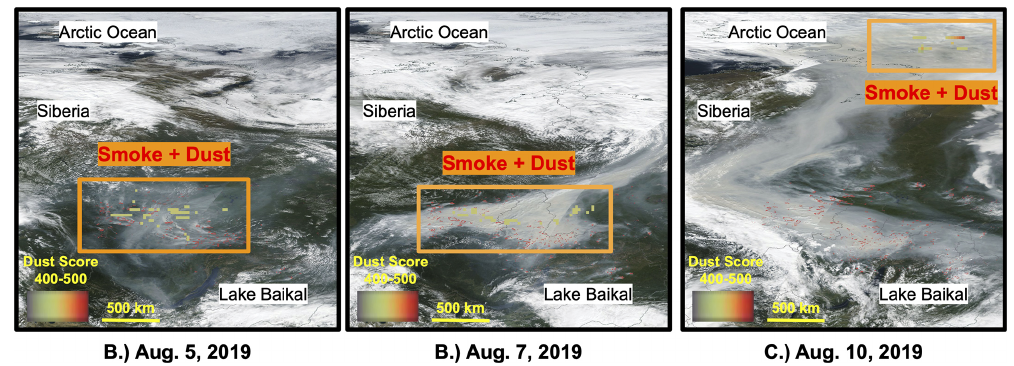
Figure 5. (a) 1 August, (b) 5 August, and (c) 10 August 2019 NASA MODIS true color satellite images of Siberian boreal forest fires. Fire and thermal anomalies shown in red dots and Dust Score values shown in pixels colored according to the embedded scale. Areas of dust score and visible smoke are outlined in orange